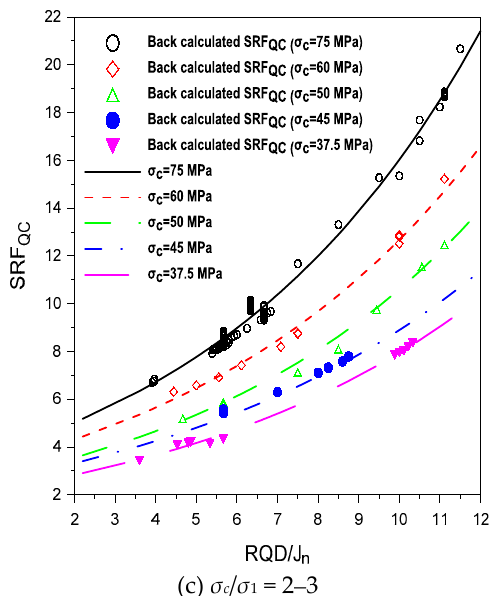
Figure 7. Variation of SRF QC with relative block size for different values and ranges of σ c and σ c / σ 1 , respectively.